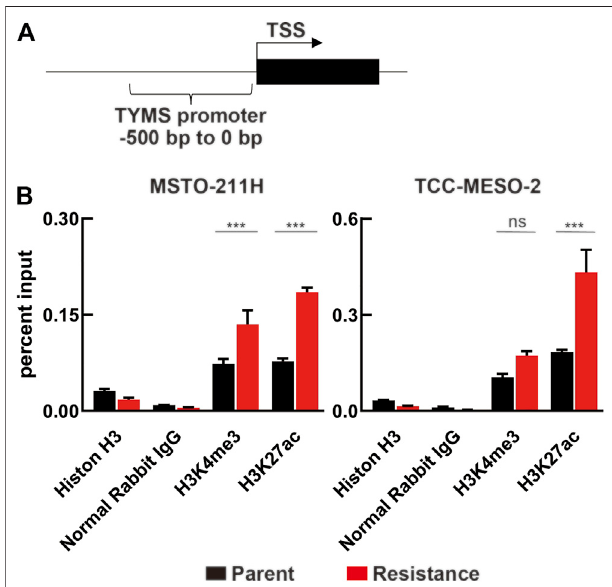
FIGURE 6 | Changes in histone modi fi cation due to PMX-resistance in the TYMS promoter. (A) Schematic of the region 0 – 500 bp upstream of the TYMS transcription start site ( TYMS TSS). (B) Chromatin in MPM cells were immunoprecipitatedusingantibodiesagainstHistoneH3,NormalRabbit IgG, H3K4me3, and H3K27ac, and the TYMS TSS ( − 500 to 0 bp) mRNA expression was evaluated by real-time RT-PCR and normalized to input DNA. Error bars indicate the range of SD. ns, not signi fi cant, * p < 0.05, ** p < 0.01, *** p < 0.001 vs. parent cell by Two-way ANOVA using for graph pad